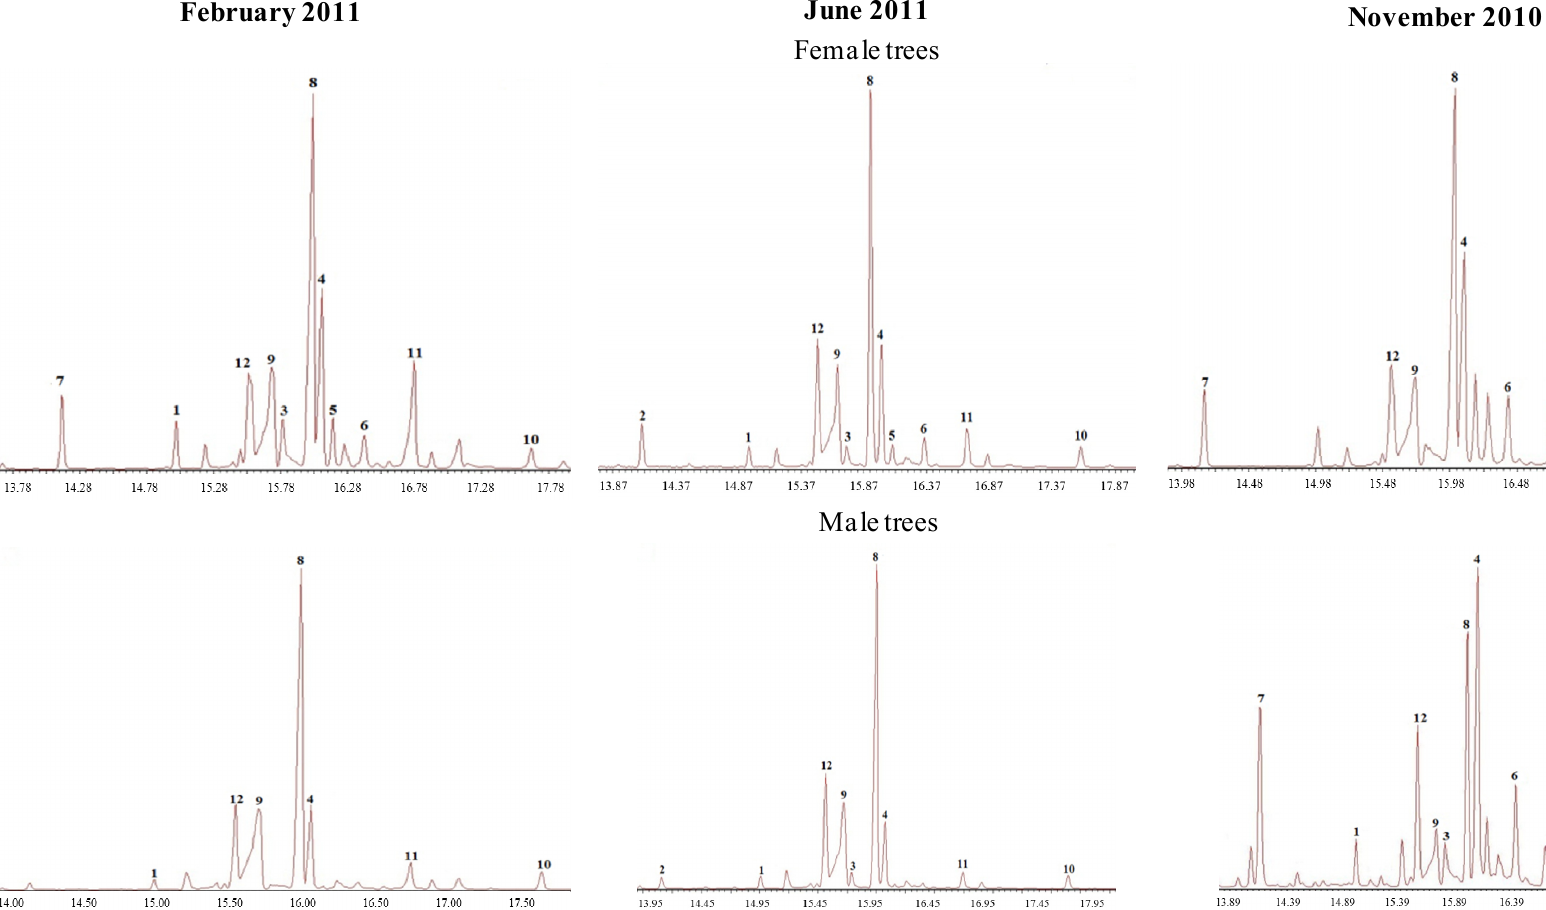
Figure 2. Gas chromatography traces of female and male Austrocedrus chilensis resin samples collected in different seasons of the year (as methyl esters). Compounds were identified by comparison with standards isolated from the resin and comparison of the mass fragmentation patterns with literature. Compounds: 1 : 18-hydroxy isopimar-15-ene; 3 : isopimara-8(9), 15-dien-19-ol; 4 : sandaracopimaric acid methyl